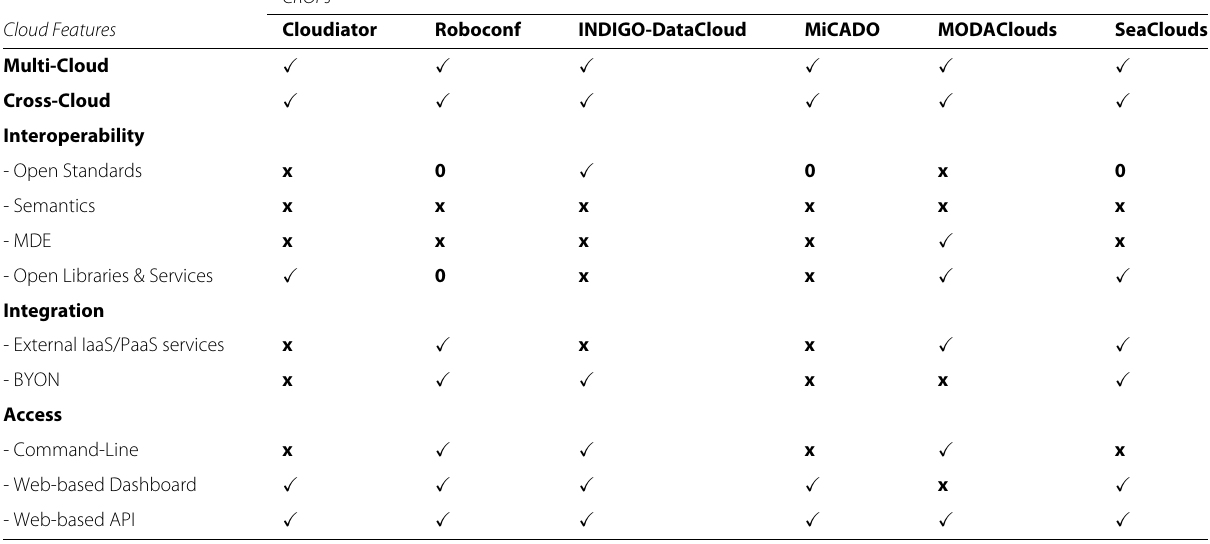
Table 4 Cloud-based comparison of experimental/research CROFs CROFs CloudFeatures Cloudiator Roboconf INDIGO-DataCloud MiCADO MODAClouds SeaClouds Multi-Cloud